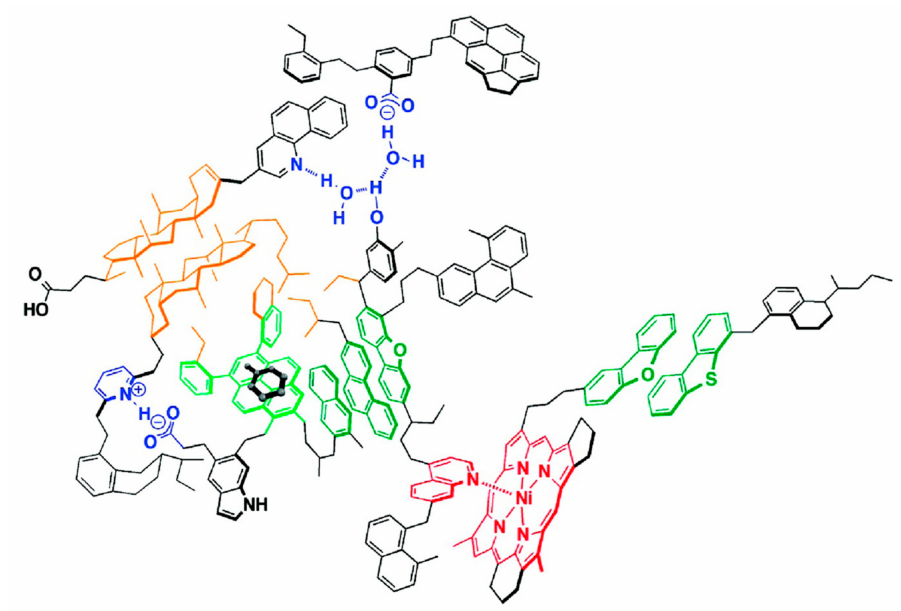
Figure 5. Supramolecular assembly model of asphaltene proposed by Murray R. Gray et al.